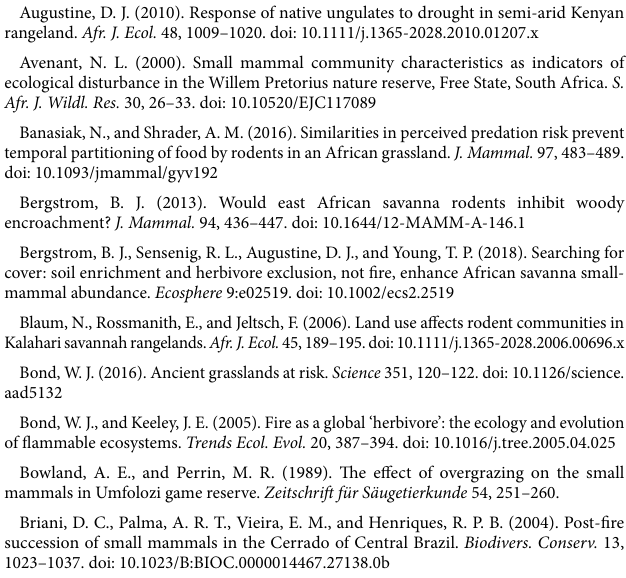
SUPPLEMENTARY TABLE S1 Spreadsheet summarizing methods and findings of 63 published field studies of effects of endogenous disturbances on small-mammal communities in tropical savanna ecosystems. Details of explanatory and response variables, study type, disturbance type, effects and effect sizes, and authors’ conclusions about mechanism(s) for significant responses.